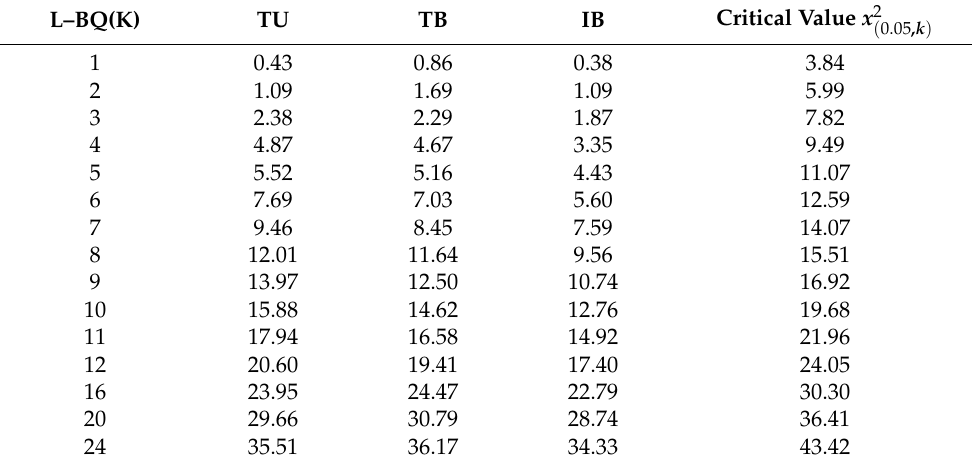
Table 2. Results of Ljung–Box Serial Examination for 3 VOCs.